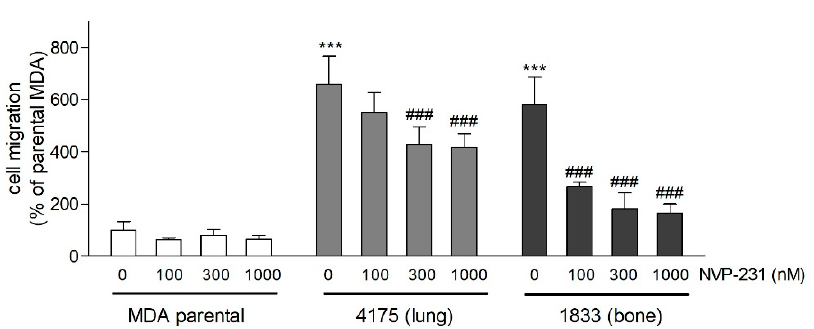
Figure 2. E ff ect of the CerK inhibitor NVP-231 on cell migration of parental and metastatic MDA-MB-231 cells. 5 × 10 4 parental MDA-MB-231 cells (open columns), lung metastatic (4175, light grey columns), and bone metastatic (1833, dark grey columns) cells were seeded onto transwell filters and treated for 20 h with either vehicle (0) or the indicated concentrations of the CerK inhibitor NVP-231 in Dulbecco’s Modified Eagle Medium (DMEM) / 1% fetal bovine serum (FBS). Migrated cells were determined as described in the Methods section. Representative pictures are shown in Supplementary Figure S2. Data are expressed as percentage of control parental MDA-MB-231 cells migrated into the lower chamber and are the means ± SD (n = 3). *** p < 0.001 compared to vehicle-treated parental MDA-MB-231 cells; ### p < 0.001 compared to the vehicle-treated 4175 or 1833 cells.